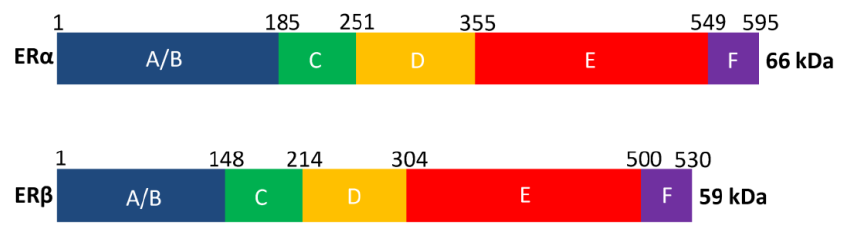
Figure 3. Domains A-F of ERα and ERβ, each playing a different structural/functional role. The numbers above the bars denote the residue numbers in the two receptor subtypes. ERα is slightly larger than ERβ, with a total of 595 amino acids (66 kDa) compared to 530 amino acids (59 kDa) for ERβ.